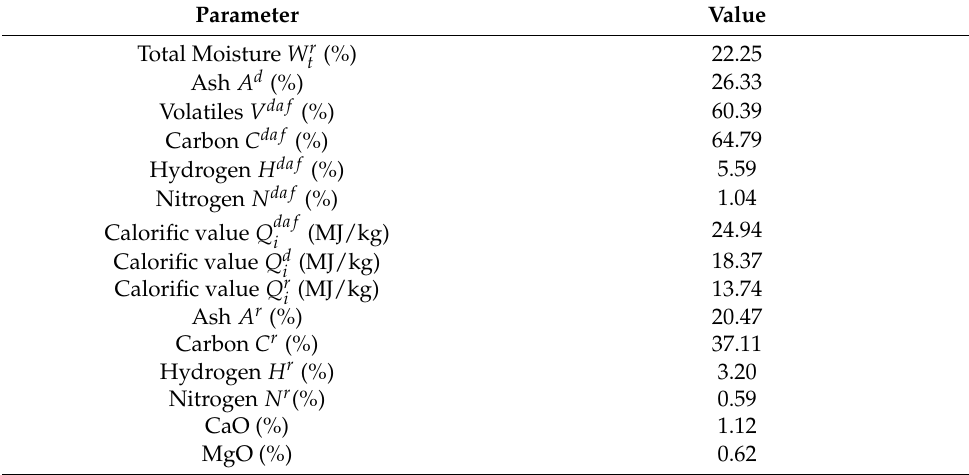
Table 1. Coal composition analysis ( r = received, d = dry, daf = dry ash-free, and a = analytical)